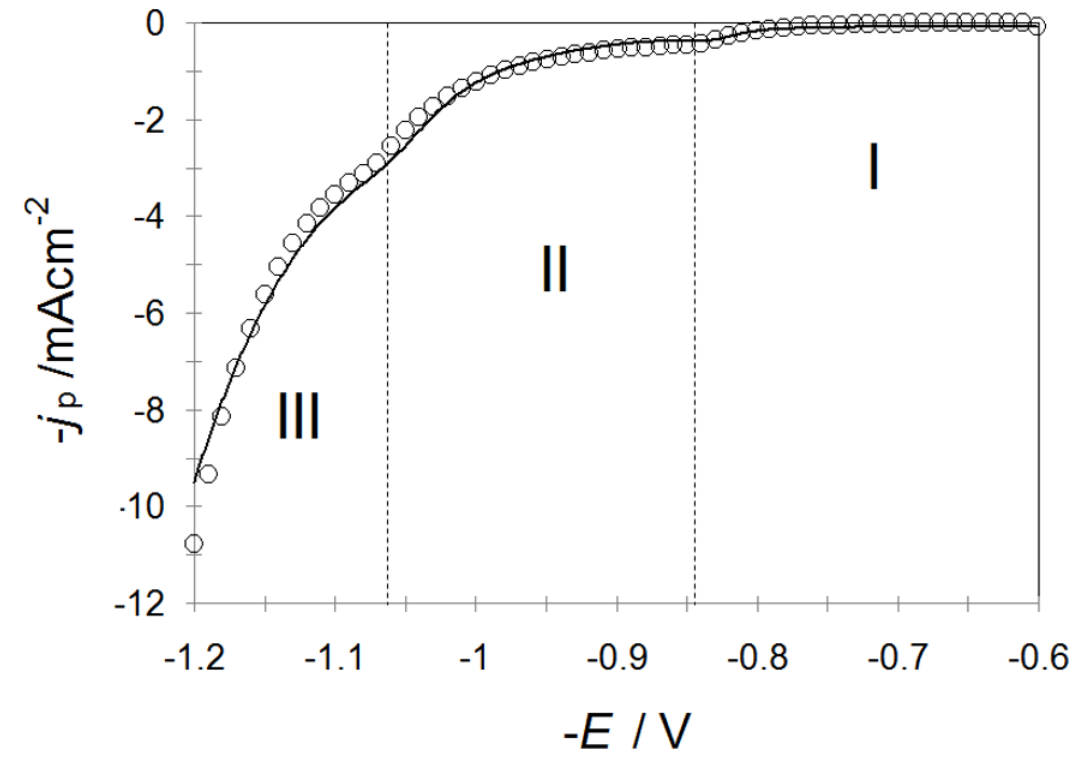
Figure 4. Comparison of an experimental linear cathodic voltammogram recorded during cobalt electrodeposition at the potential range [-600 mV to -1200 mV] onto a polycrystalline gold from an aqueous in the system 0.01M CoSO LCV (open circles) obtained by non-linear fit of Eq. 1. r